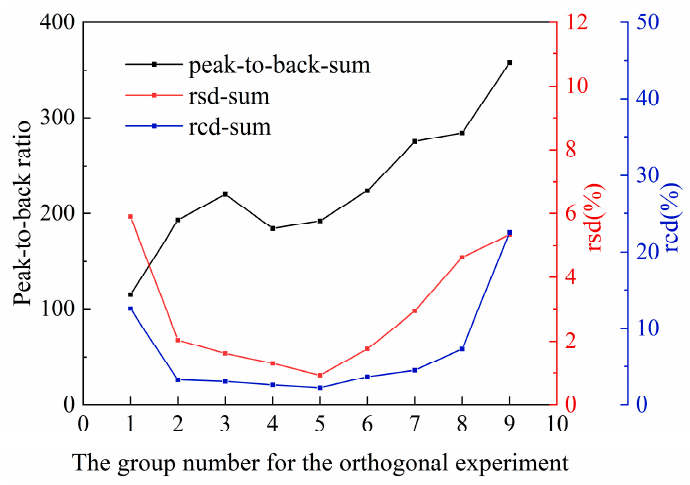
Figure 3. The corresponding peak-to-back ratio, the relative standard deviation and the relative content deviation of orthogonal